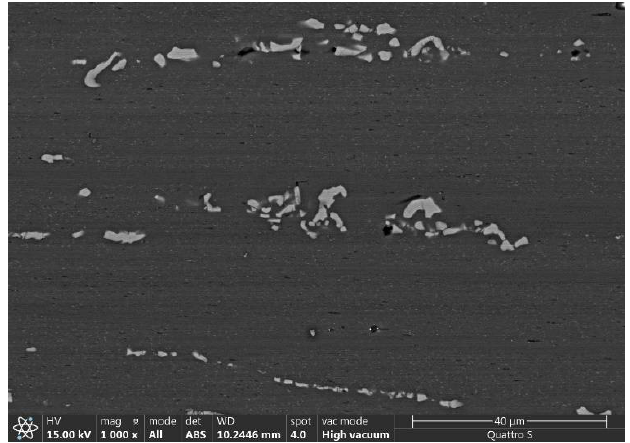
Figure 1. The microstructure of extruded aluminum alloy 6082 from the optical microscope.